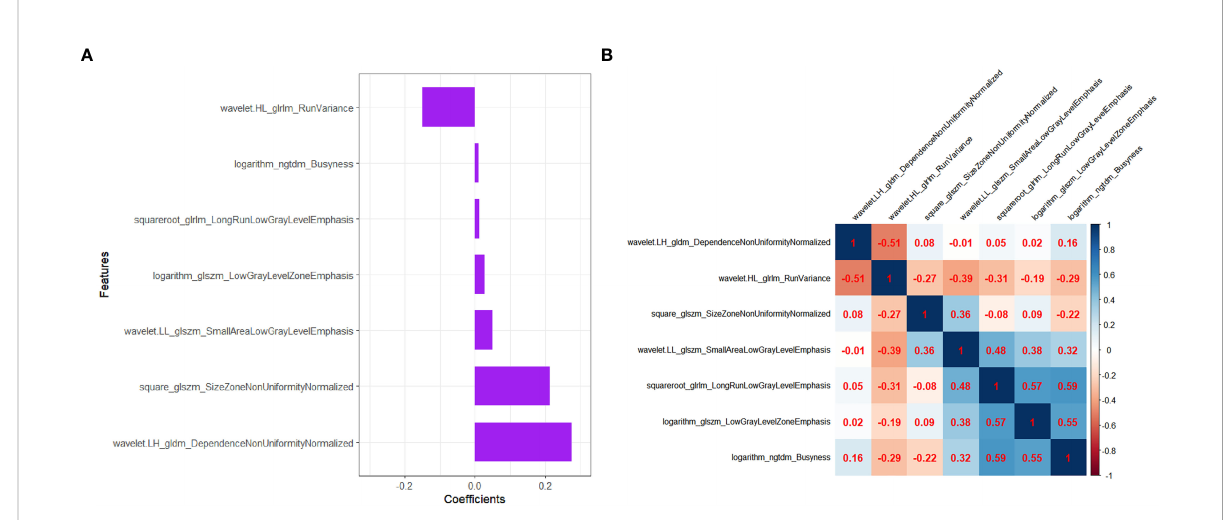
FIGURE 3 The selected radiomics features to construct the Radscore. (A) The coef fi cients of radiomics features in the construction of Radscore. (B) Heatmap depicting correlation coef fi cient matrix of the selected radiomics features associated with LVI. The degree of correlation between various features is shown in different shades of